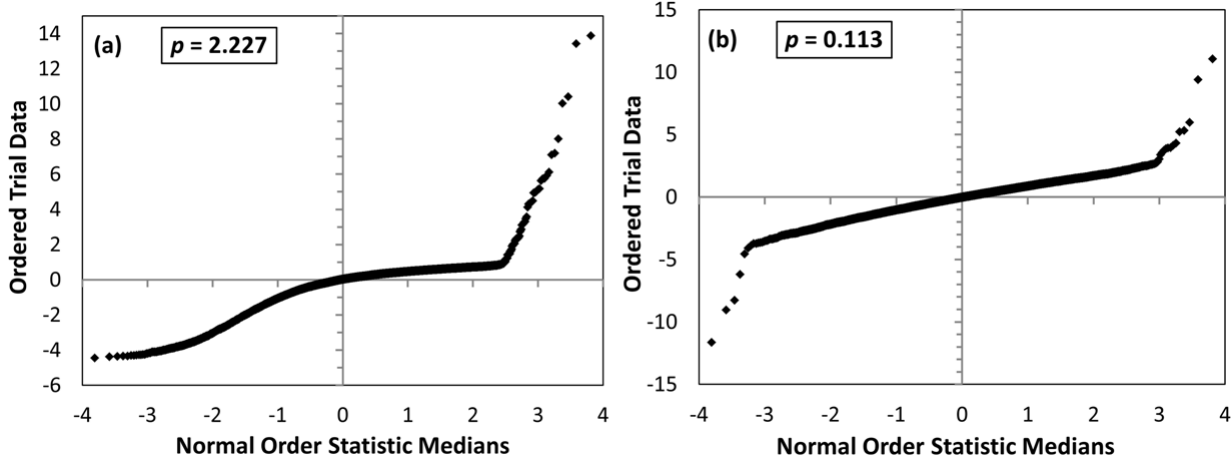
Figure 8. Examples of normal probability plots for abnormal transitions (see text). ( a ) 5 D – 3 P2 M1 transition, λ = 3,837.58 Å, A = 4 × 10 − 5 s − 1 , |CF| = 2(4) × 10 − 6 ; ( b ) 1 G2 2 2 E2 transition, λ = 2.252 μ m, A = 1.56 × 10 − 17 s − 1 , |CF| = 0.0824(13). In both panels, the data are plotted for an optimal Box–Cox transformation with the parameter p shown in boxes.